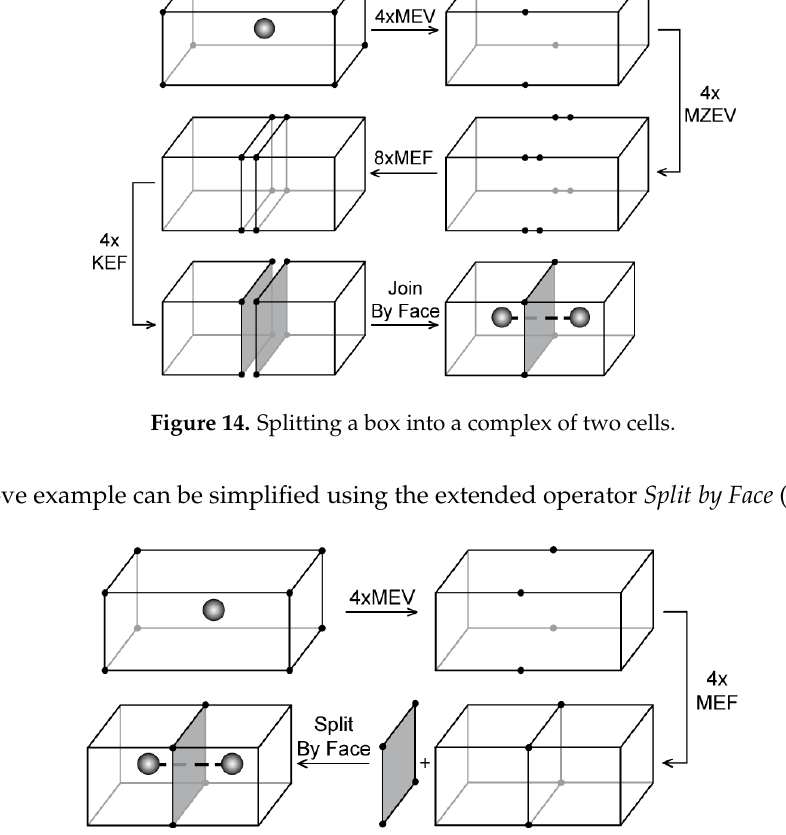
Figure 15. Splitting a box into a complex of two cells using the Split by Face operator.